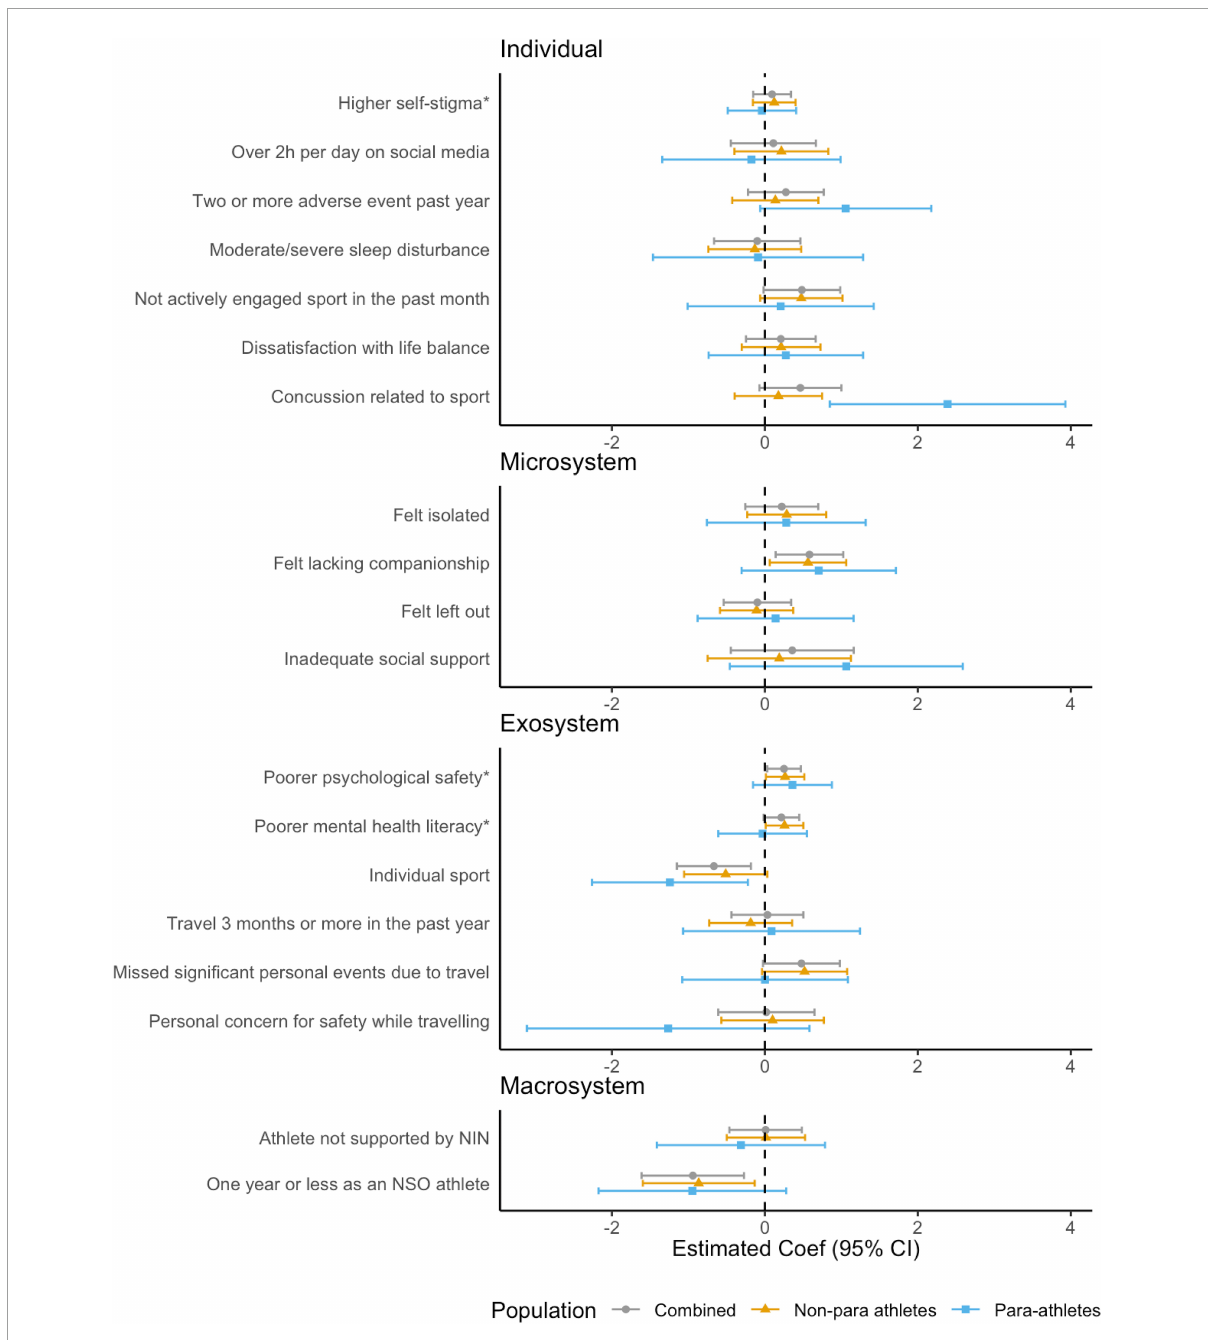
FIGURE3 Associations between risk factors and risky alcohol consumption (AUDIT-C) for combined, non-para and para athletes, adjusted for age and gender. *Effects associated with one standard deviation ( SD ) change in Psychological Safety subscales (Low Self-Stigma, Mentally Healthy Environment, and Mental Health